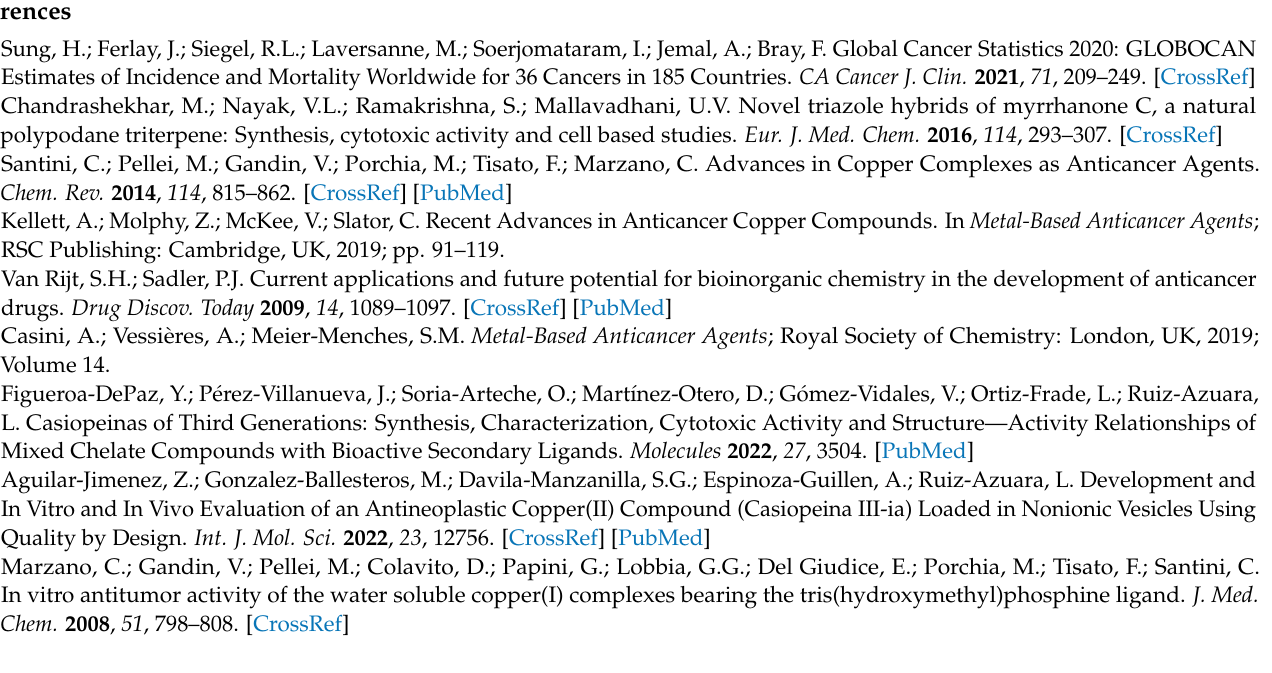
structure of compound 3. Table S1: DNA binding constants ( K b ) determined by the Benesi–Hildebrand method. For comparison, previously determined values of related complexes are also included. Table S2: Approximate DNA slope of the variation of the viscosity induced by the binding of the complexes. Table S3: Selectivity index of the compounds (SI, IC 50 on non-tumor cells/IC 50 on tumor cells of related